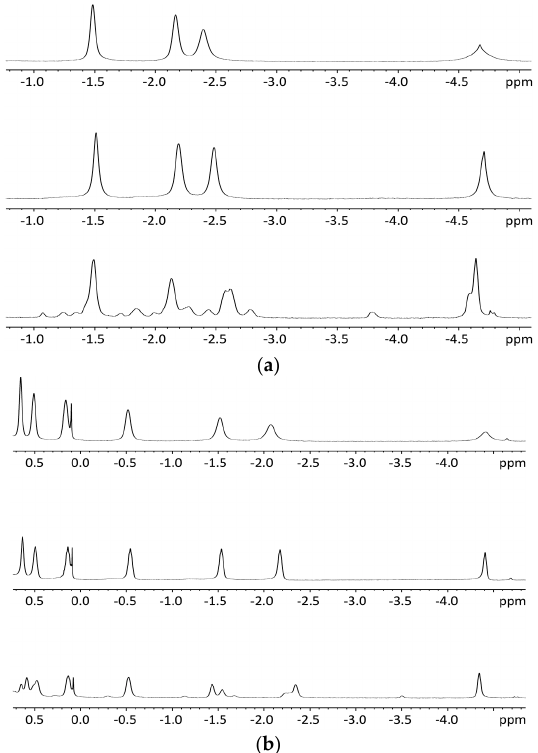
Figure 8. Variable temperature 1 H-NMR spectra (500 MHz), ( a ): 1:1 complex of enediyne tweezer Z - 1 and 1,6-diaminohexane 21 in CDCl 3 . Top: 25 °C Middle: 0 °C Bo tt om: − 55 °C; ( b ): 1:1 complex of enediyne tweezer Z - 1 and 1,12-diaminododecane 22 in CDCl 3 . Top: 25 °C, Middle: 0 °C, Bo tt om: − 55 °C.